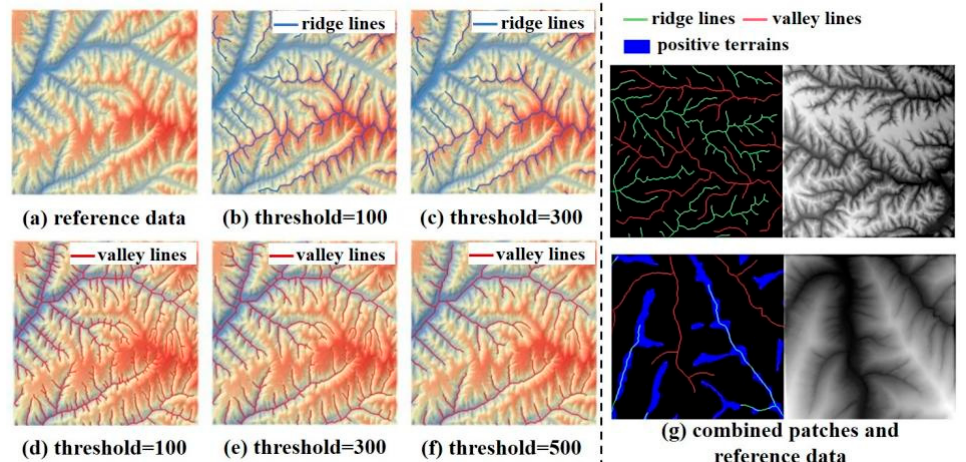
Figure 2. Representation of input patches. ( a ) Reference DEM; ( b , c ) The extraction of ridge lines based on different thresholds; ( d – f ) the extraction of valley lines on different thresholds; ( g ) the patches combining ridge lines, valley lines, positive terrains, and the corresponding DEM.